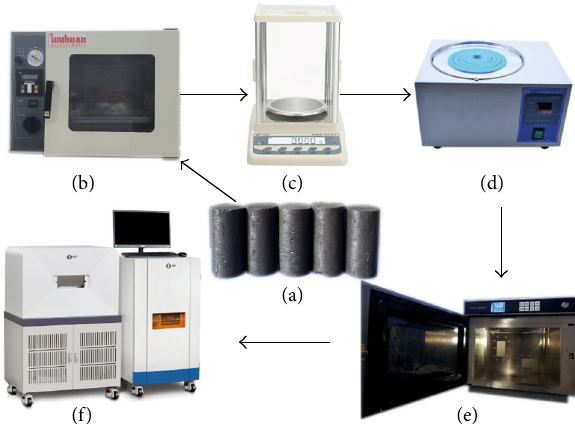
Figure 1: Test process of microwave heating of water-bearing coal rock: (a) coal samples, (b) WUHUAN ZK-2020 vacuum drying oven, (c) Di Heng 456A electronic balance, (d) HH-S constant- temperature water bath box, (e) New Sail microwave oven, and (f) MesoMR23-060H NMR testing